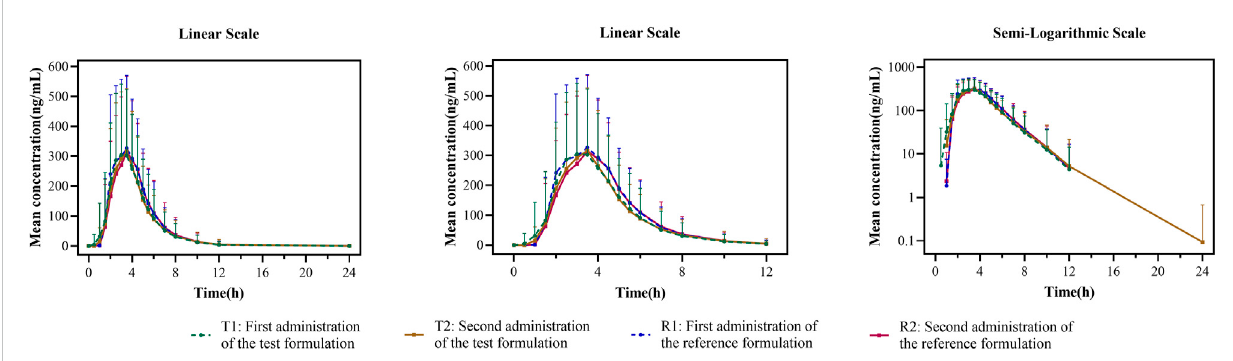
FIGURE 3 Mean plasma concentration – time curves for the test and reference formulations after a single dose of 20 mg of the esomeprazole enteric-coated tabletinhealthysubjectsunderfedconditions. N =40.BarsrepresentSD.T1: fi rstadministrationofthetestformulation;T2:secondadministration ofthe test formulation; R1: fi rst administration of the reference formulation; R2: second administration of the reference formulation.